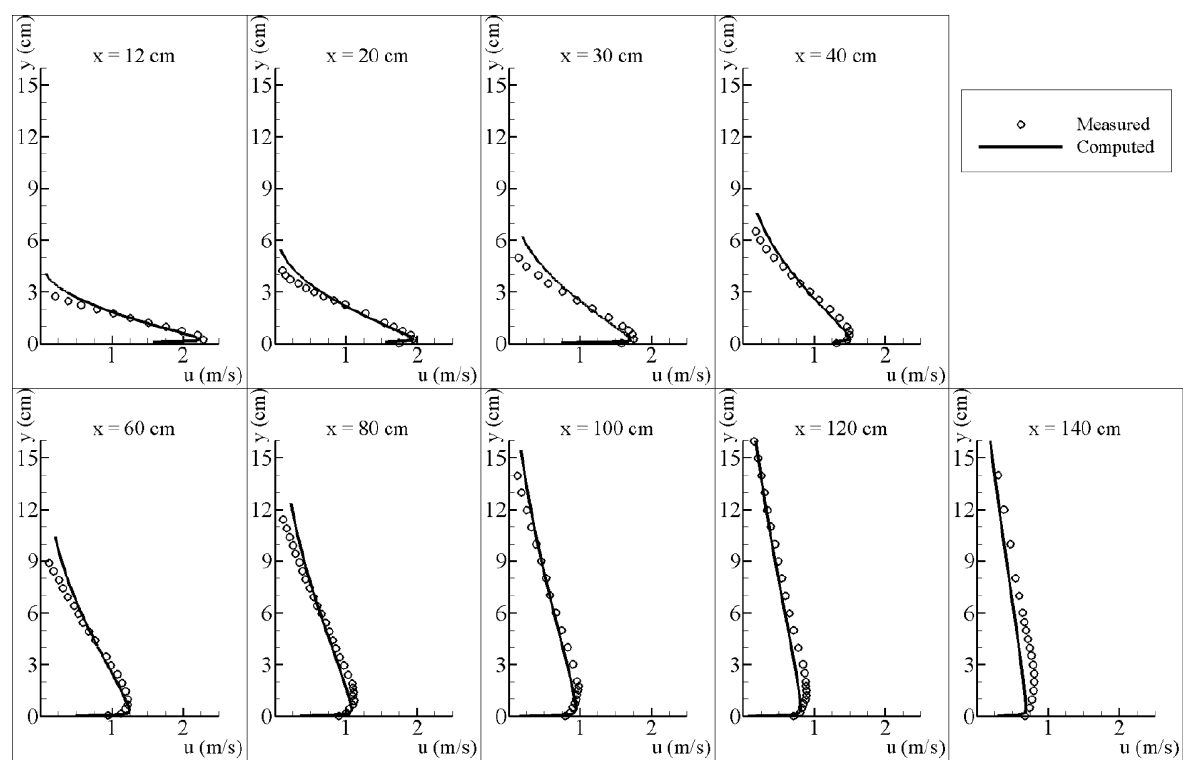
Fig. 4. Comparison of simulated velocity field with the experimental measurements of Ead and Rajaratnam (2002) (Experiment 1).